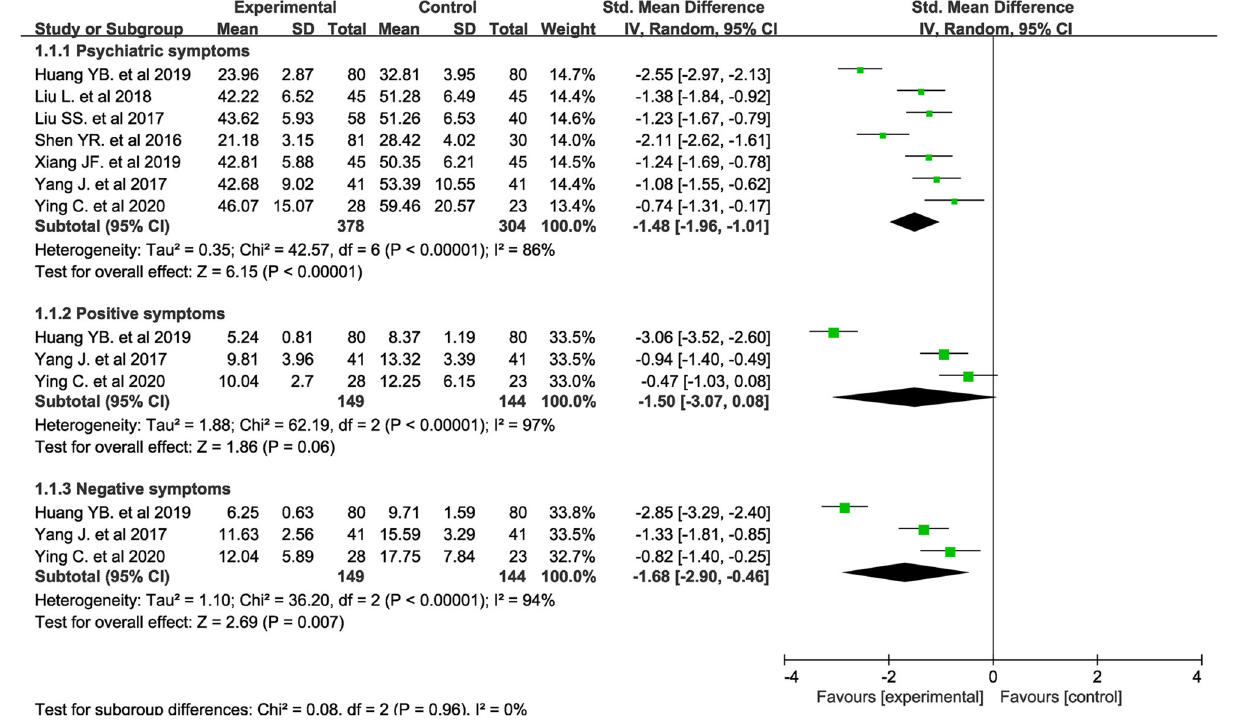
FIGURE 2 | Forest plot about the treatment effectiveness of the clubhouse model of psychiatric rehabilitation on psychiatric symptoms, negative symptoms, and positive